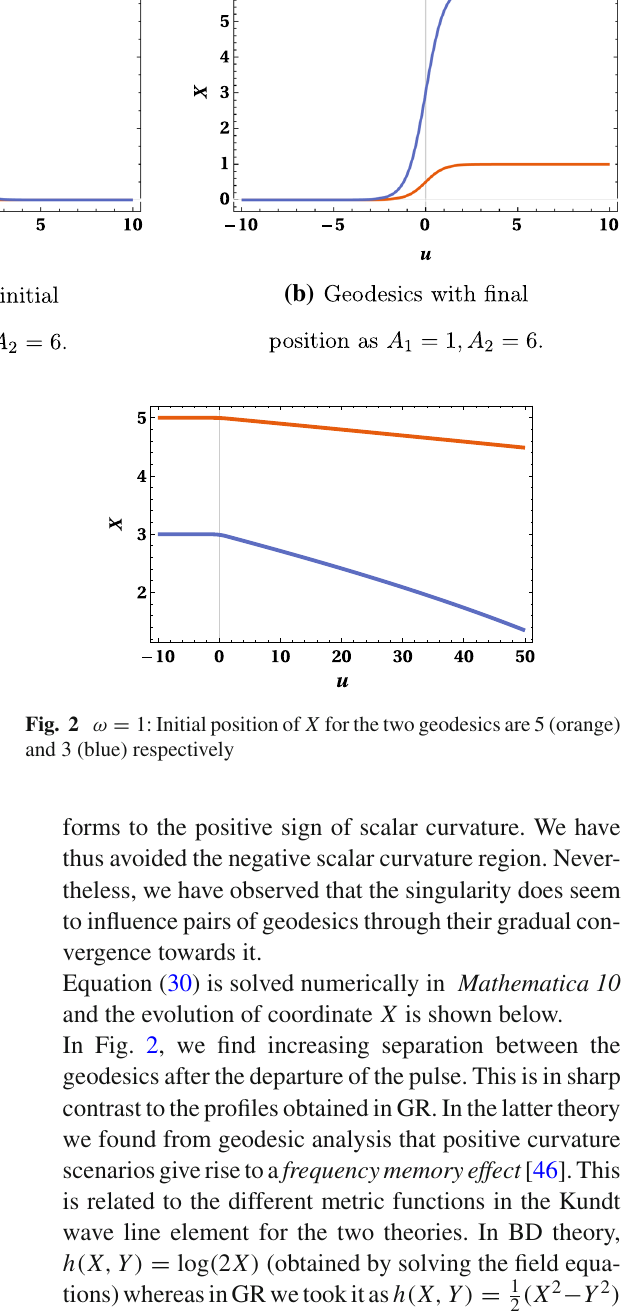
Fig. 1 Displacement memory effect for Kundt waves with ω = − 2